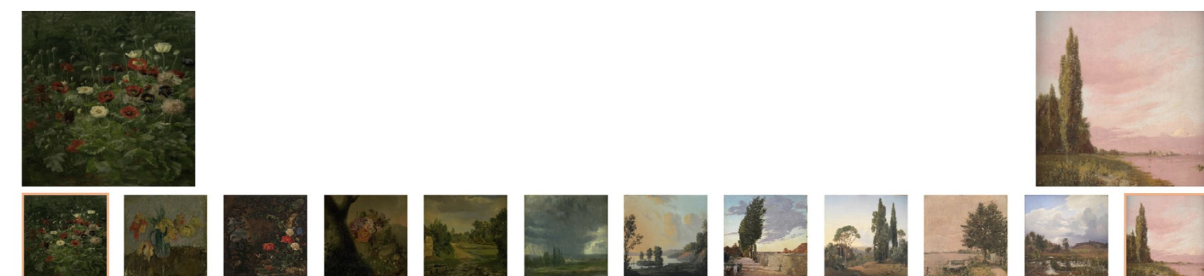
Figure 14. Walk through the high-dimensional space from one artwork to another . D. Bönisch. The